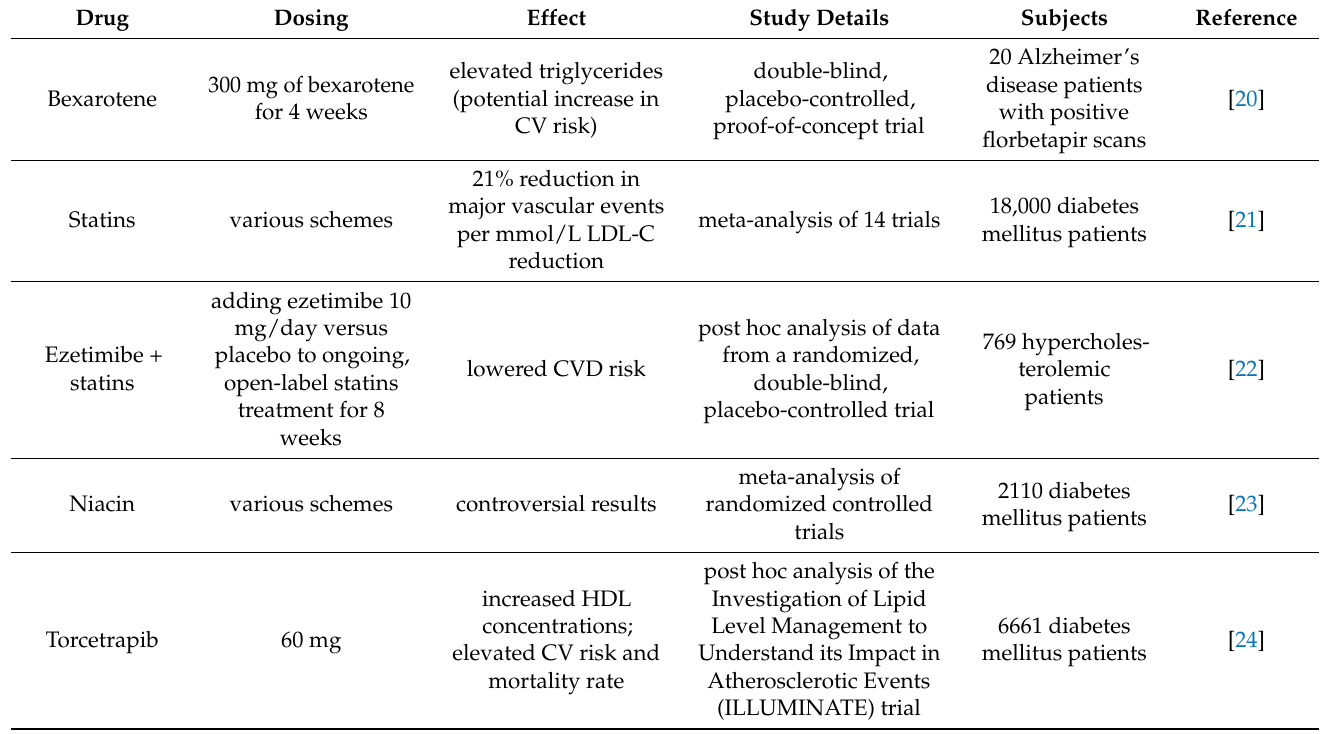
Table 2. Summary of clinical studies targeting HDL in various